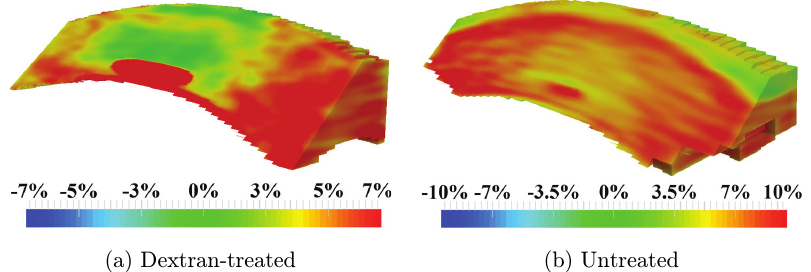
Fig. 3. (Color online) Maps of the ¯rst principal strain " 1 obtained in (a) dextran-treated, and (b) untreated globes after in°ation from 10 mmHg to 12 mmHg.